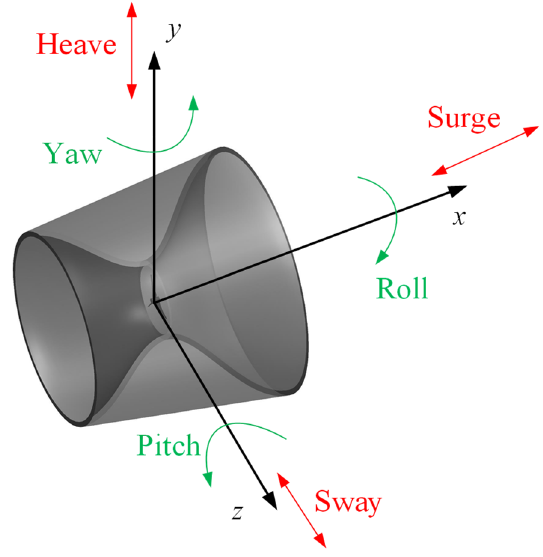
Figure 7. The six degrees of freedom (6DoF) motions of an